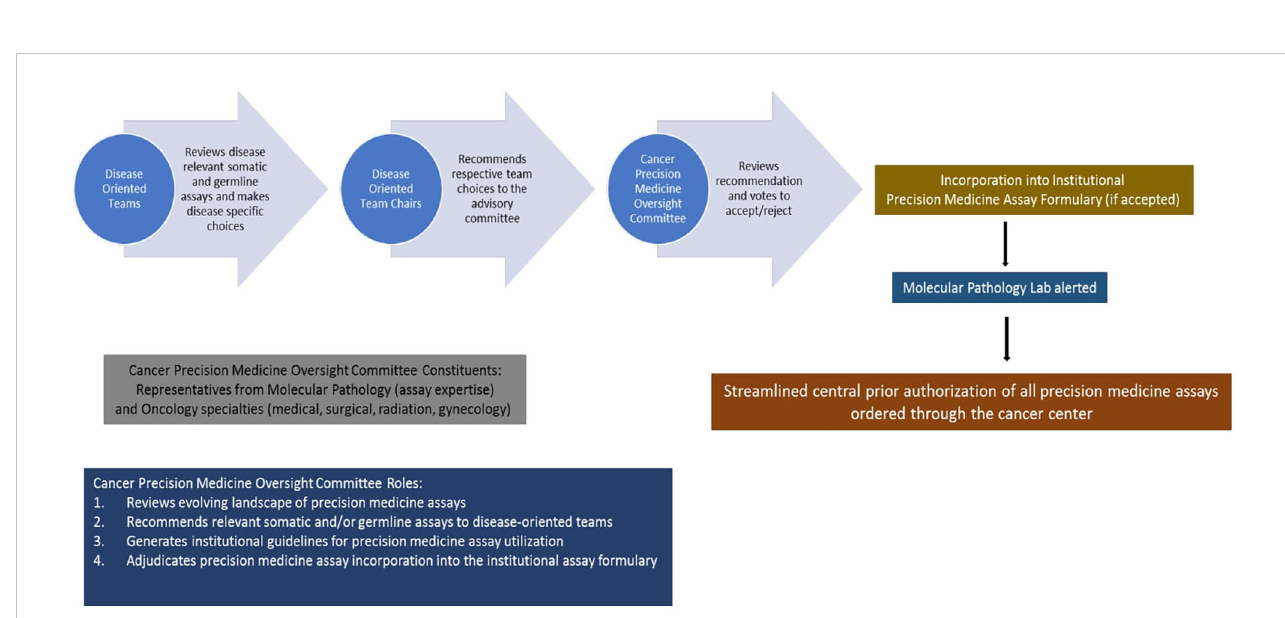
FIGURE 7 Proposed framework for selection, utilization, and implementation of cancer precision medicine assays based on current work fl ow at the Medical College of Wisconsin Cancer